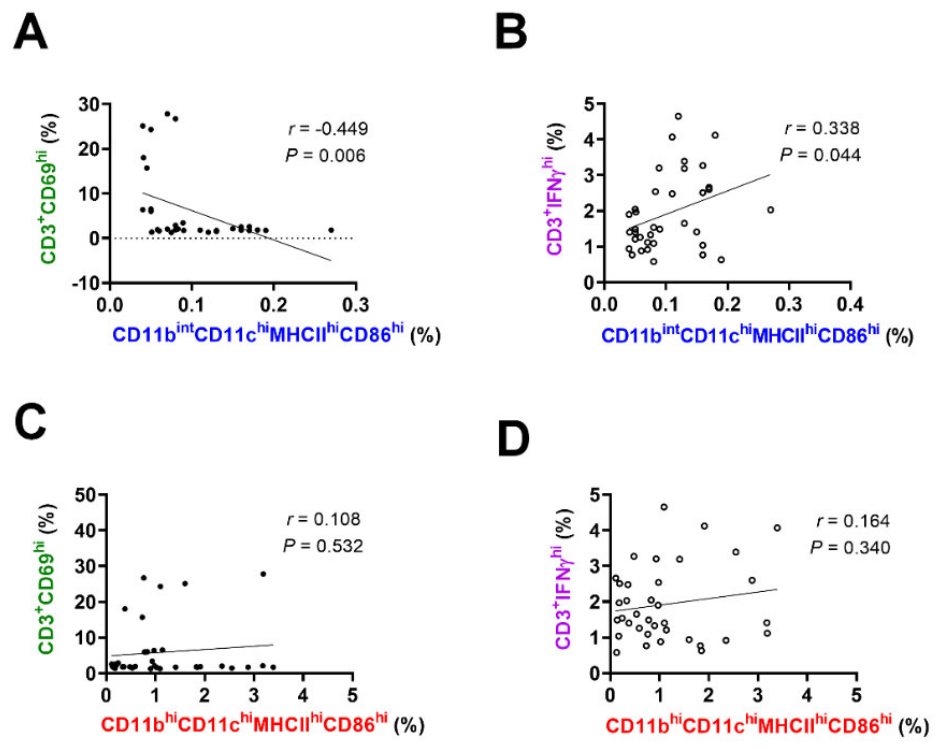
Figure 4. Simple linear regression analysis of the T cell proportion related to the ocular APC subsets. ( A , B ) The frequency (% of total) of ocular CD69 hi T cells was negatively correlated with the frequency of the CD11b int CD11c hi MHCII hi CD86 hi cells in the surface, whereas the frequency of IFN γ hi T cells was positively correlated with the frequency of the CD11b int CD11c hi MHCII hi CD86 hi cells. ( C , D ) The frequency of the CD11b hi CD11c hi MHCII hi CD86 hi cells did not correlate with the frequency of T cell subsets. n = 36 pairs per analysis. Abbreviations: APC, antigen-presenting cell, IFN γ , interferon gamma.